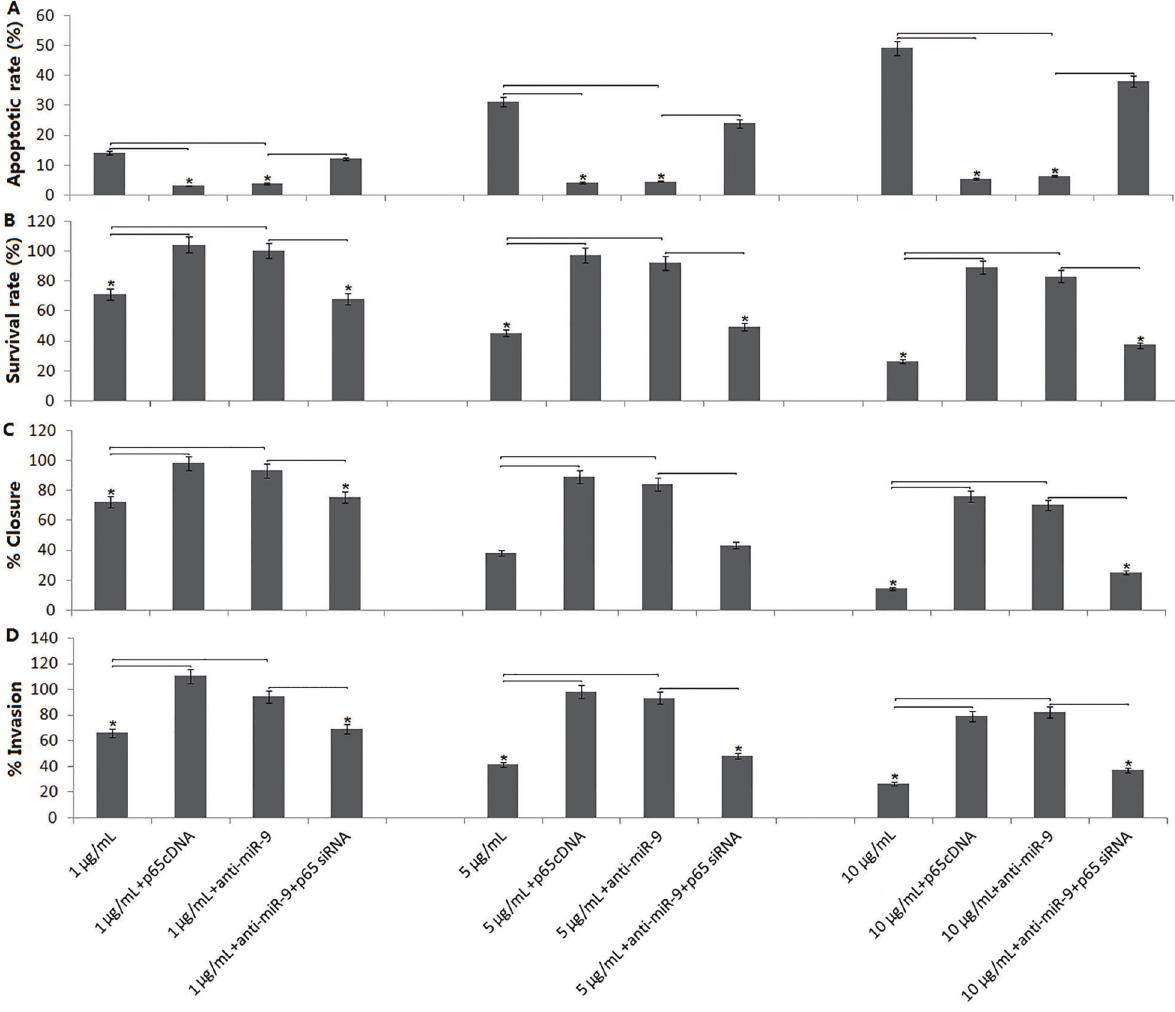
Figure 4. Effect of miR-9/NF- k B /MMP-9 signal on propofol-induced apoptosis and invasion. ES-2 cells were transfected with anti-miR-9 or p65 siRNA or p65 cDNA for 24 h, and then treated with 1, 5, and 10 m g/mL propofol for 6 h. A , Cell apoptosis was detected